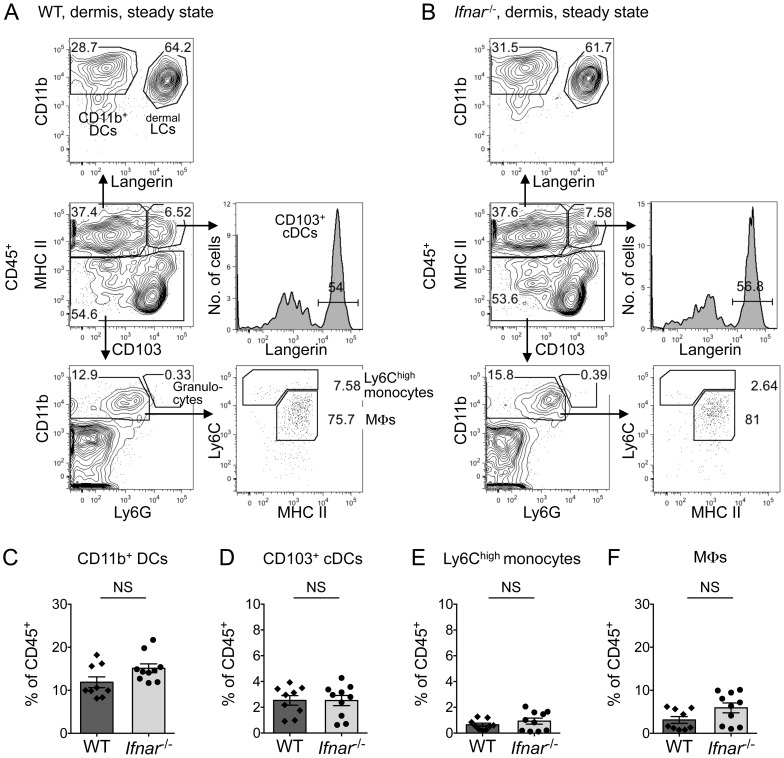
Normal cell populations in steady-state dermis of Ifnar
–/– mice.(A and B) Consecutive gating of cell populations from CD45+ cells in the dermis of steady-state WT (A) and Ifnar
–/– (B) mice. Depicted ciphers in the graphs are the % of cells in the gate relative to the parent gate. (C-F) Bar graphs showing mean ±SEM and single data points of the % CD11b+ DCs (C), CD103+ cDCs (D), and Ly6Chigh monocytes (E), and MΦs (F), as gated in A and B, and calculated as frequency among all CD45+ cells in the steady-state dermis. Data are pooled from 3 independent experiments (n = 9–10 per mouse strain), and statistical comparisons between WT and Ifnar
–/– mice are indicated (NS, non-significant). See also Figure S3.